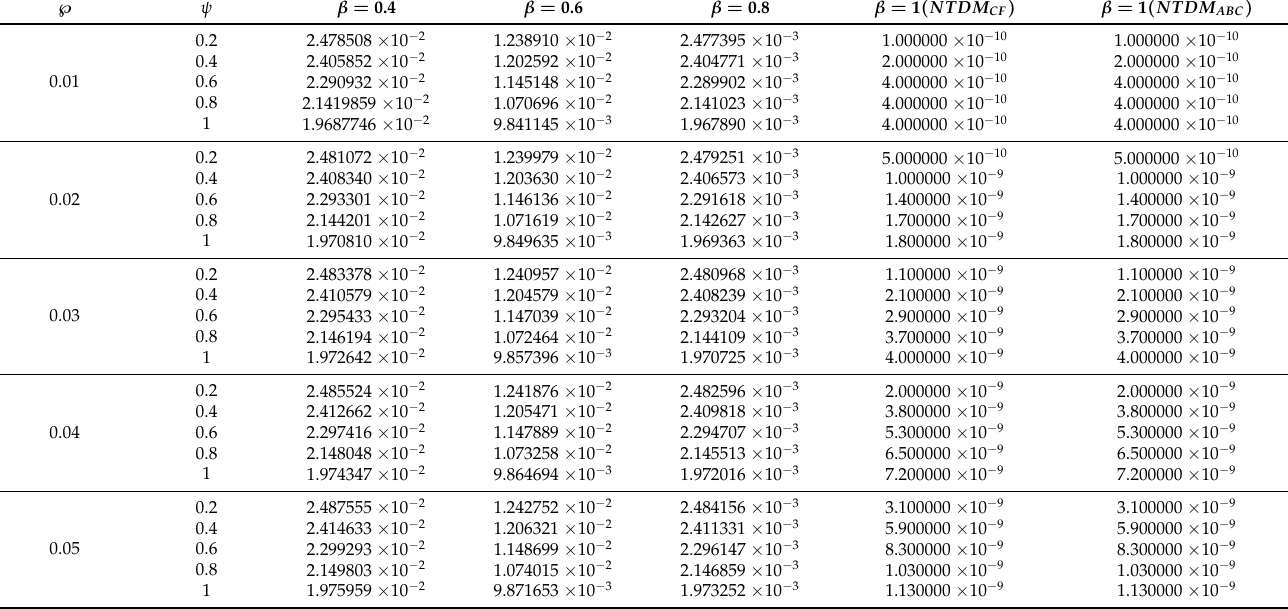
Table 1. Absolute error comparison of problem 1 at various fractional order of β .